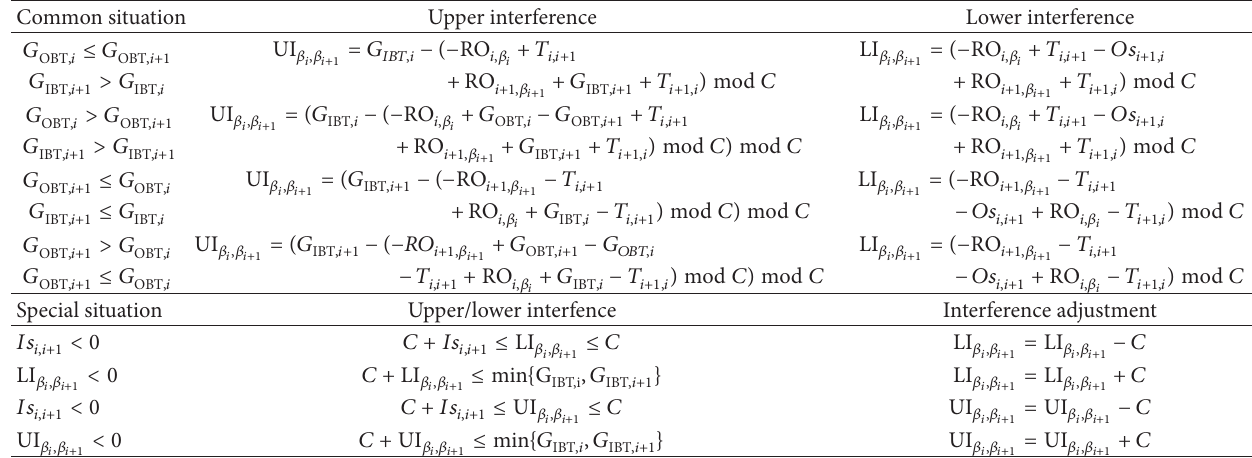
Table 1: Calculation of upper/lower interference for link